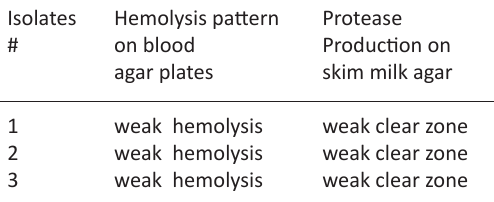
Table 1. Hemolysis pattern and protease production of S. dysenteriae